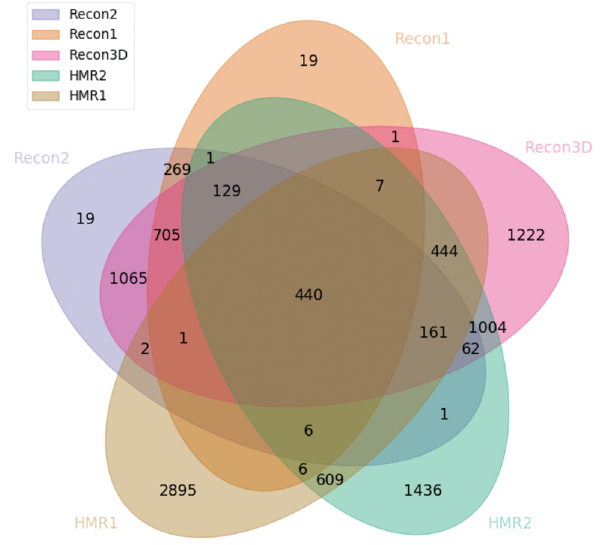
Figure 8: Venn diagram highlighting the number of reaction clusters integrated between all the main versions of Recon and HMR.